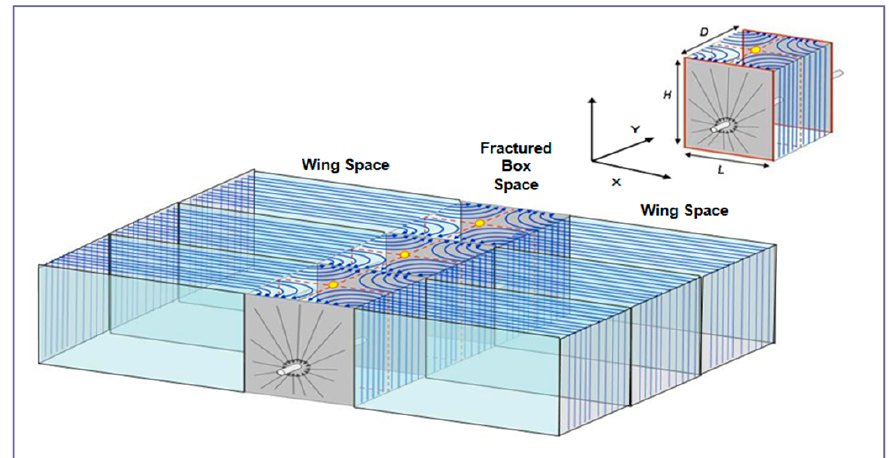
Figure 1. Principle sketch of the single elementary flow cell (inset). Blue lines are streamlines in flow cell between two sub-parallel hydraulic fractures. Main image: Three flow cells in partial section of a single horizontal well. Dashed lines are flow separation surfaces. Yellow dots are flow stagnation points (adapted from Reference [9]).